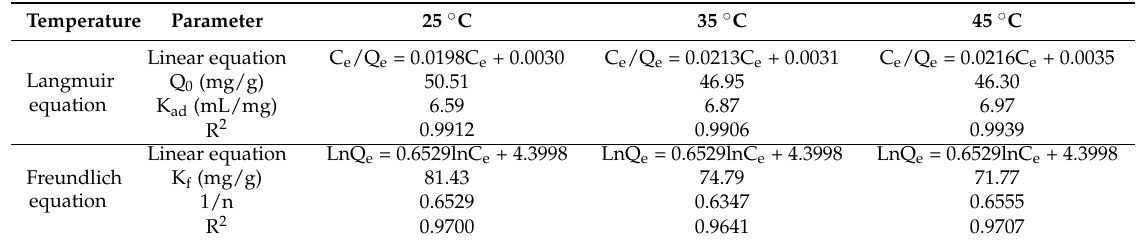
Table 2. Adsorption isotherm equations and parameters of SGslP on X-5